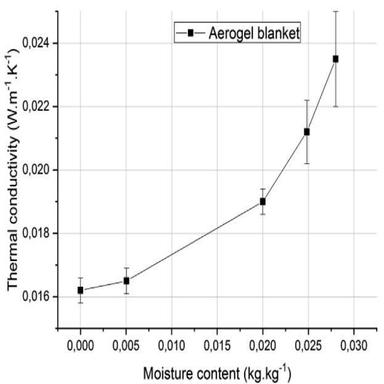
Thermal conductivity of the aerogel blanket for different moisture contents.